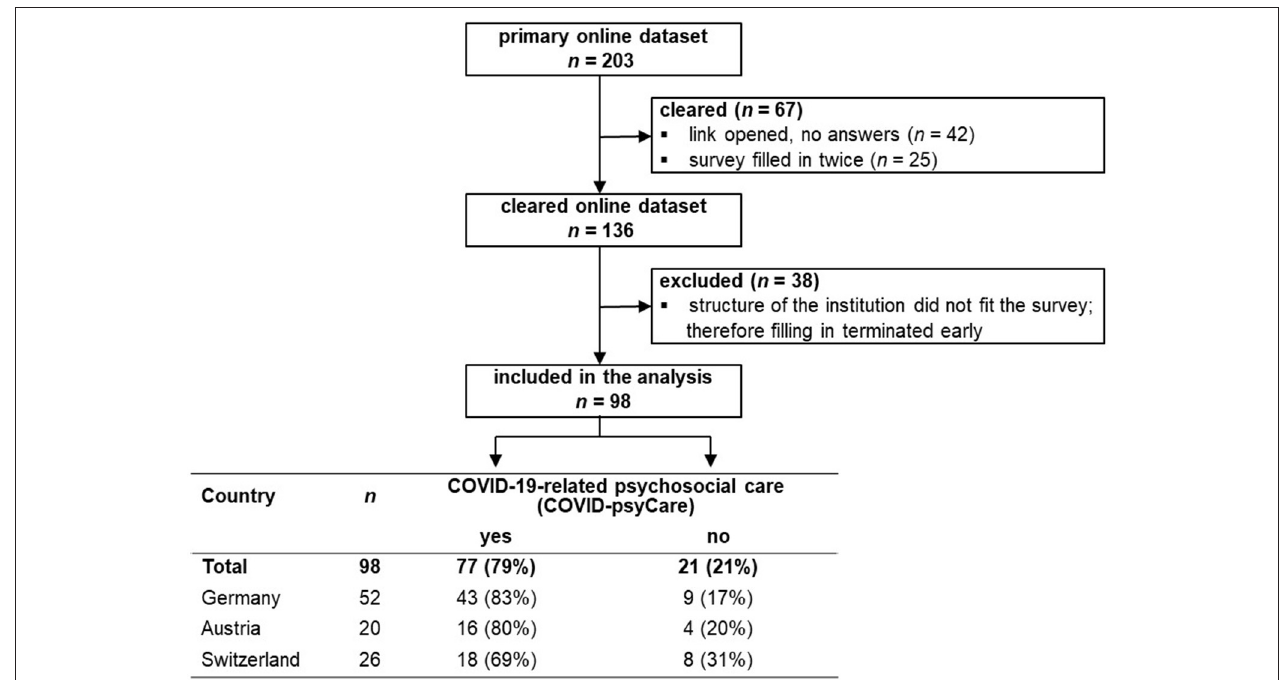
FIGURE 1 | Study flow